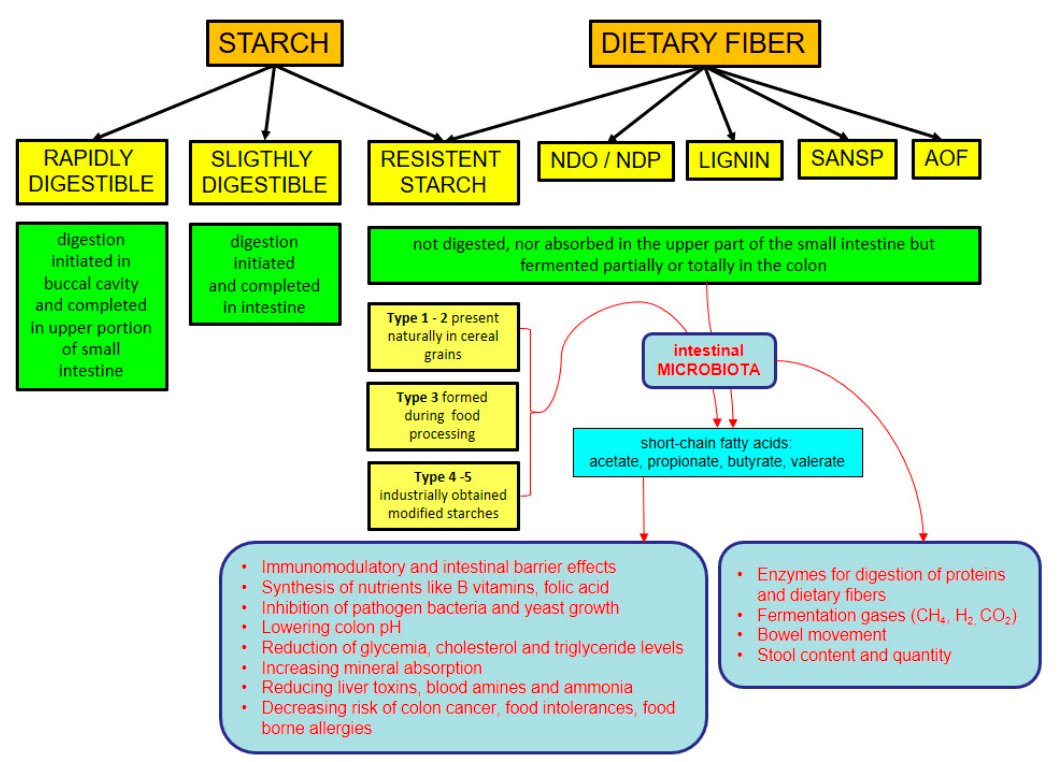
Figure 1. The comparison of some starch and dietary fiber-related properties. Note: NDO—non-digestible oligosaccha- ride; NDP—non-digestible polysaccharide (cellulose, hemicellulose, polyfructoses, gums, mucilages, pectins); SANSP—substances associated with non-starch polysaccharides (waxes, cutin, suberin); AOF—animal origin fiber (chitin, chitosan, chondroitin).